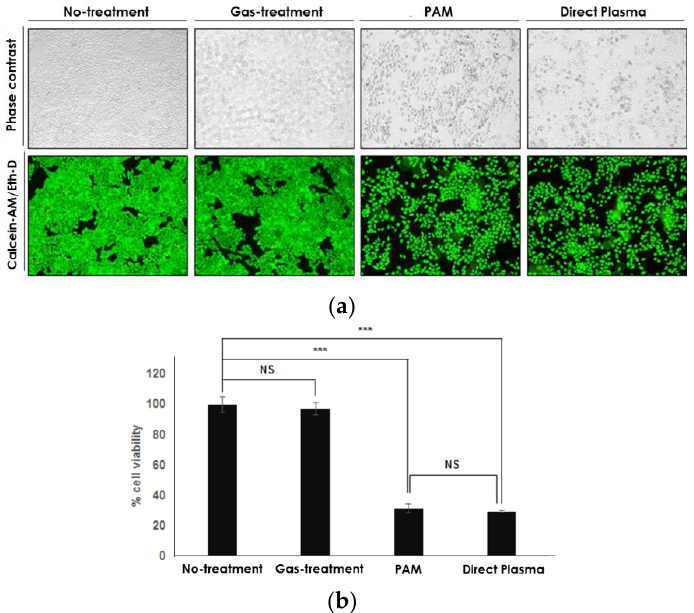
Figure 4. Comparison of anticancer effects of PAM and direct plasma. ( a ) Human cervical HeLa cancer cells were treated with either PAM or direct plasma, or gas (gas-treatment), stained with calcein-AM and EthD-1, and their viability was examined under a fluorescence microscope. ( b ) Cell viability and activity were assessed by MTT assay and compared to those of untreated or gas-treated control cells. NS, not significant; *p 0.05, **p 0.01, ***p 0.001.